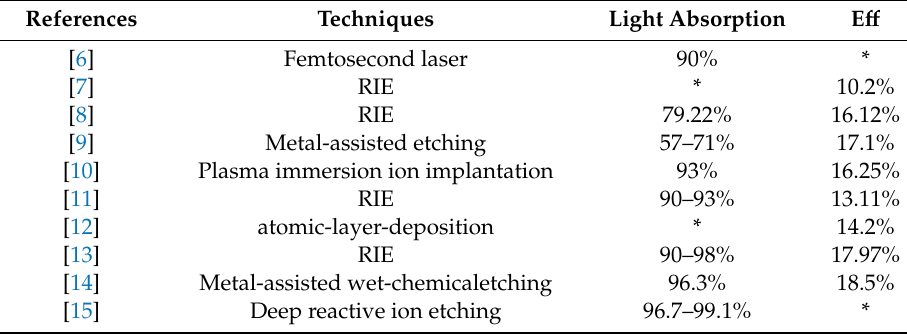
Table 1. Di ff erent black silicon PV cells and their electrical performance